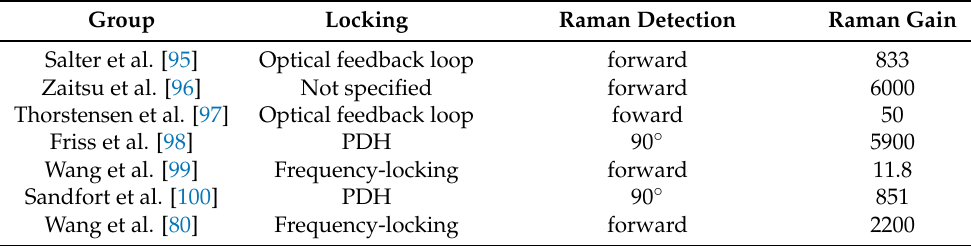
Table 4. Raman gains of resonant